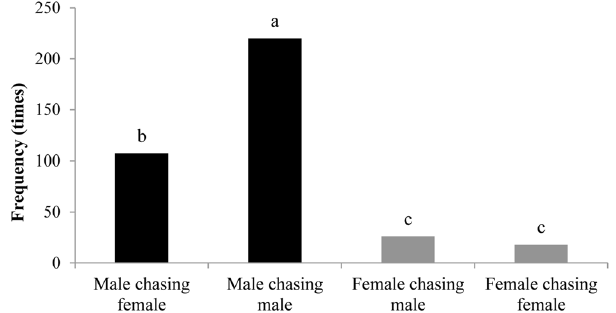
Figure 1. The frequency of occurrence of the four categories of chase during courtship of Cethosia cyane cyane .